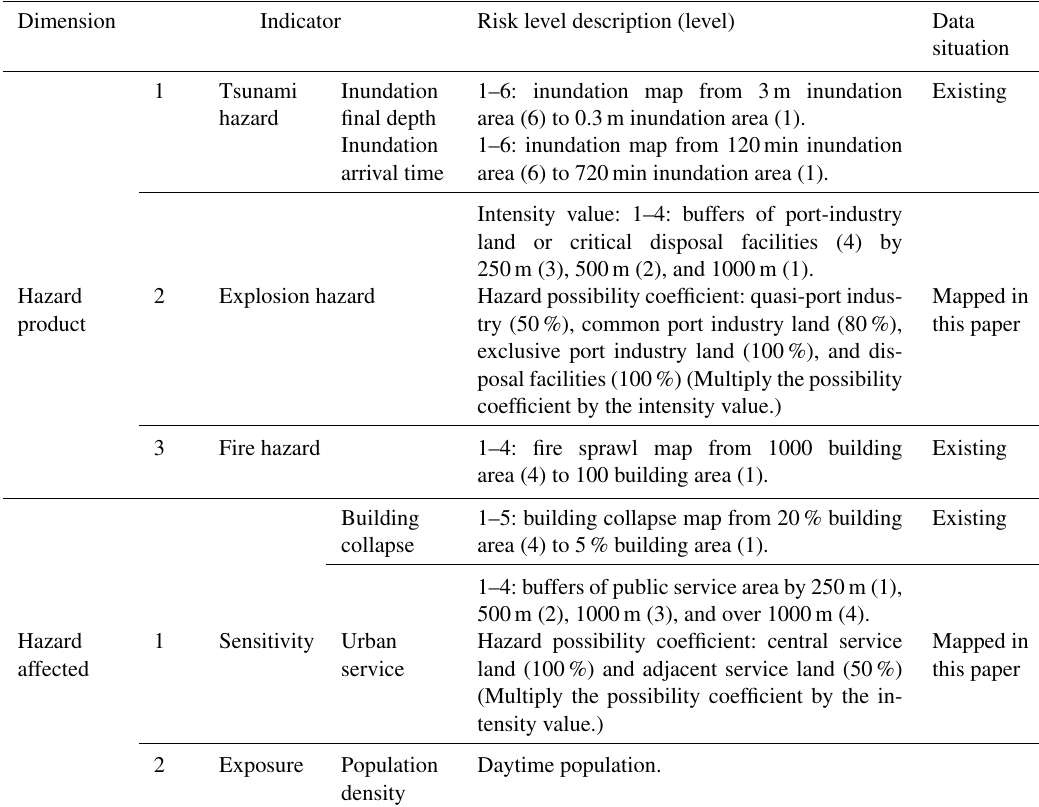
Table 3. List of indicators computed in the hazard risk evaluation. Dimension